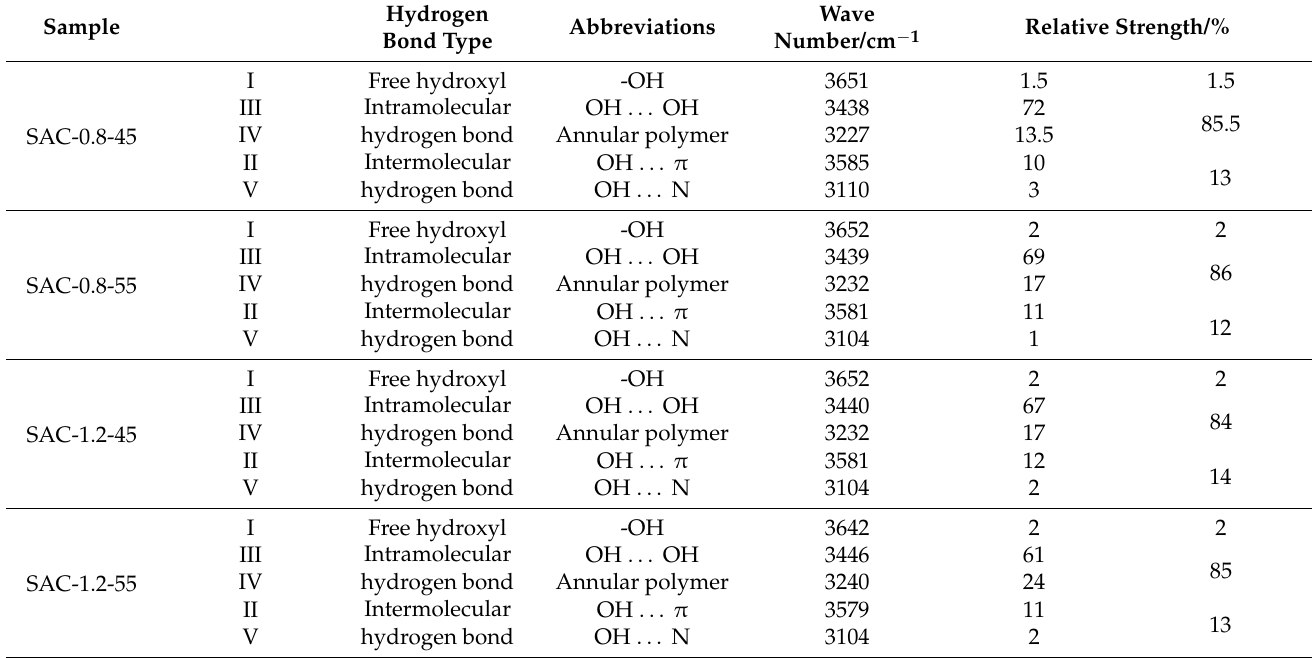
Table 2. The fitting results of various kinds of hydrogen